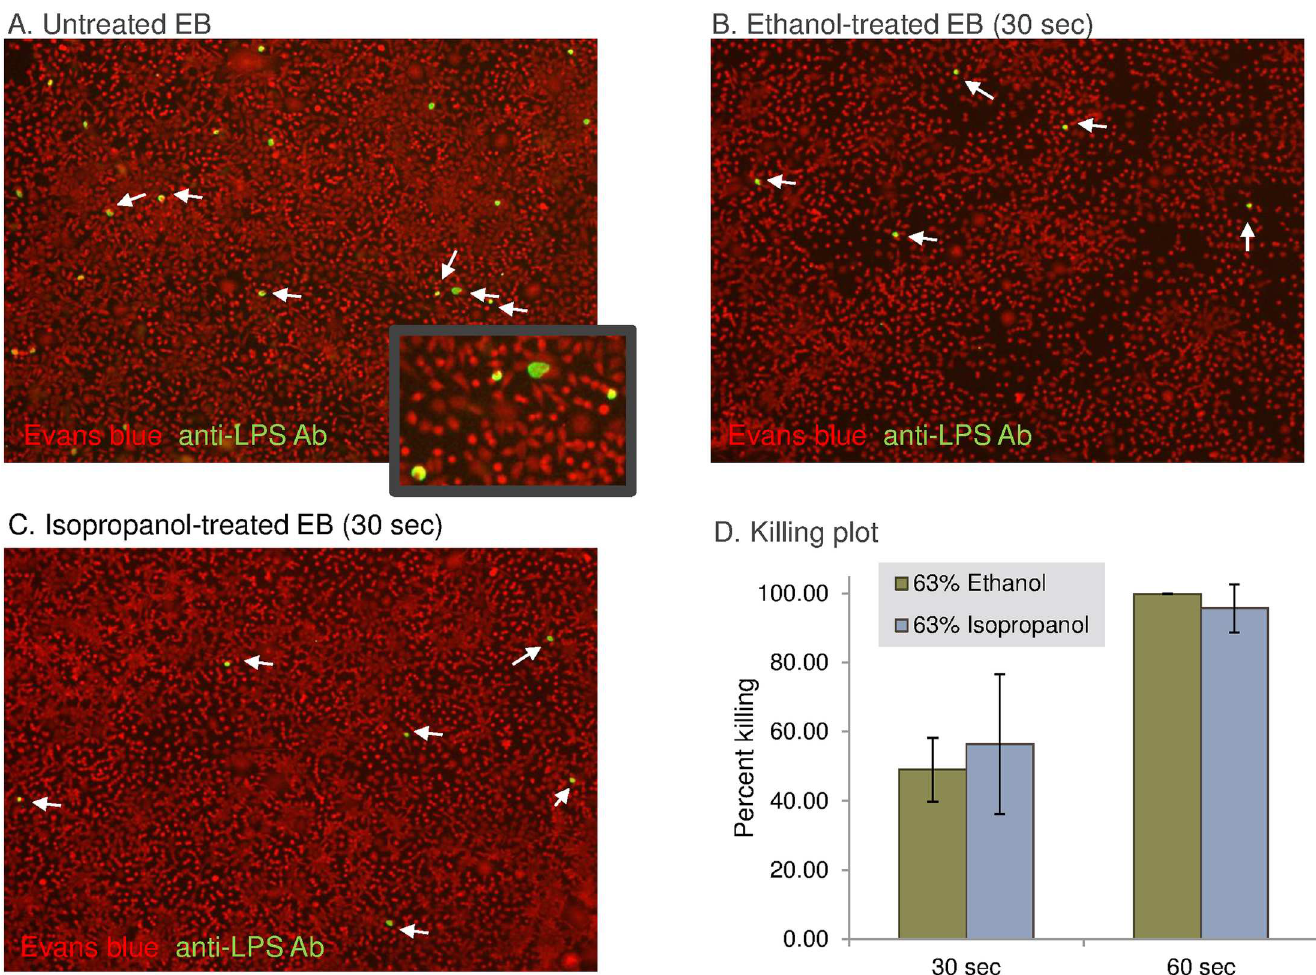
Fig 6. Elementary bodies of C . trachomatis are killed by ethanol and isopropanol. (A) Fluorescence micrograph of a monolayerof L929 fibroblasts infected at an MOI of 1:10 with mock-treated C . trachomatis ocular serovar A2497 EBs. C . trachomatis inclusionsstain green (arrows), whileL929 cells are counterstained red. In contrast, after exposure for 30 sec to 63% ethanol(B) or 63% isopropanol (C), the development of inclusionsis markedly reduced. After 60 sec treatment, few to no inclusionswere visiblein the wells. Images shot through the 10X objective.(D) Quantitative cultures of the alcoholtreated EBs were compared to the mock treated EBs to calculatethe percent killing. Shownaboveare the mean +/- standard deviationof triplicate wells. Data is representative of three independent